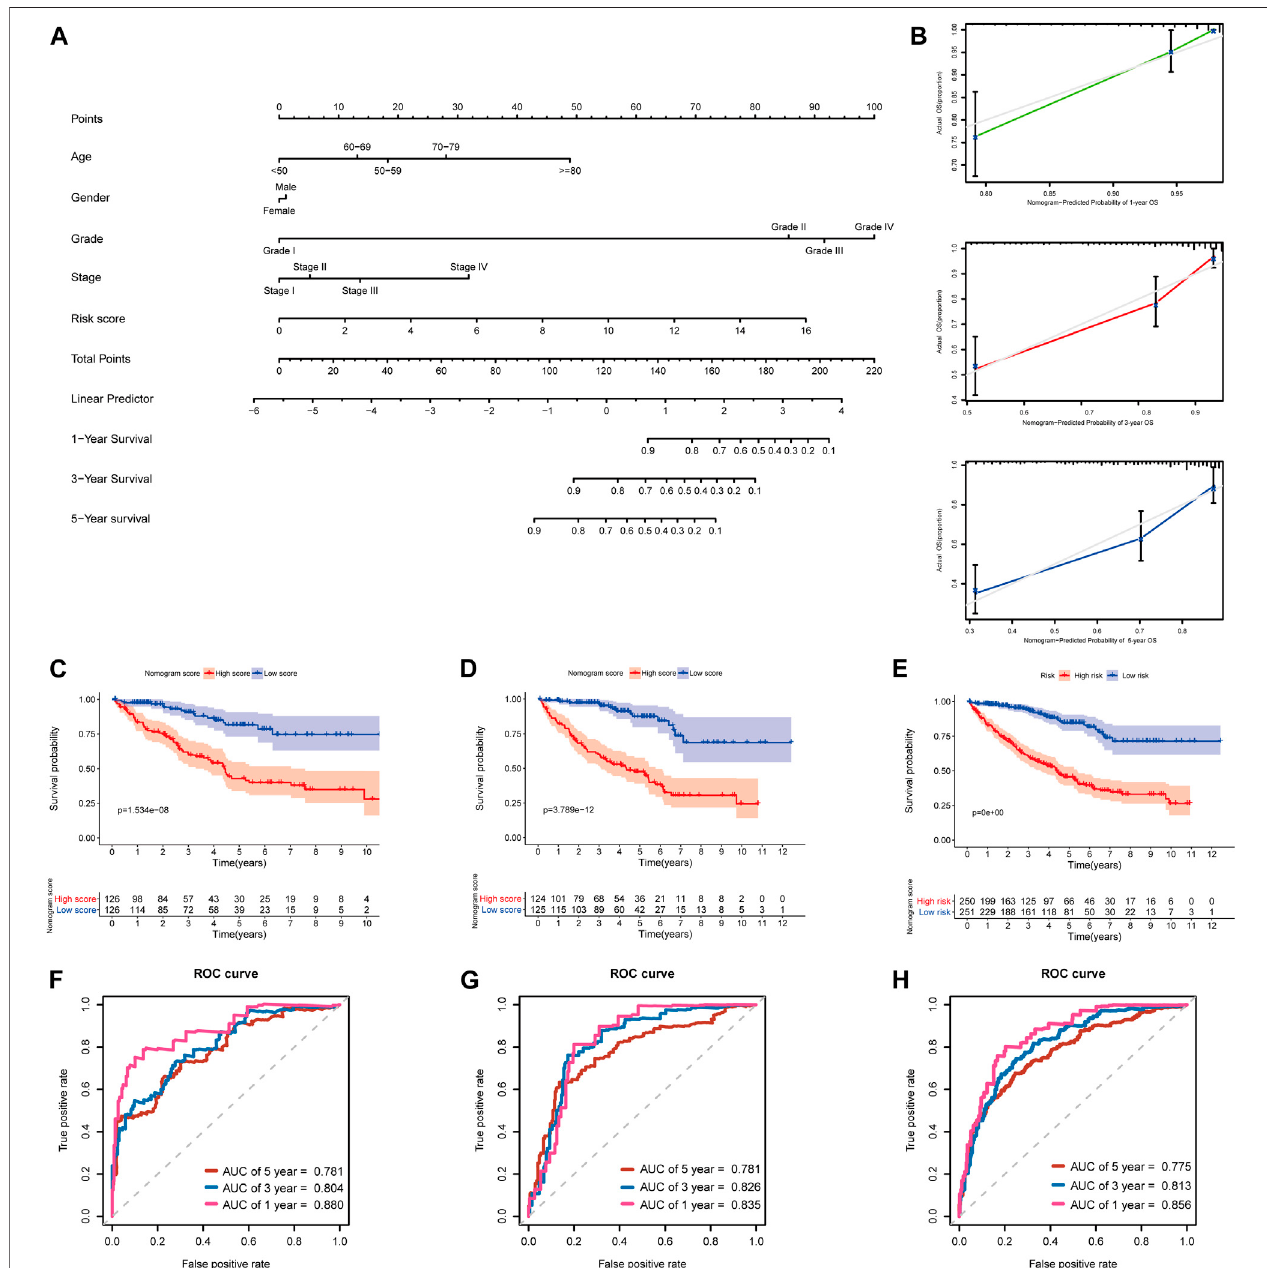
FIGURE 11 | Developing and validating a nomogram for predicting prognosis in the TCGA-KIRC dataset. (A) Nomogram constructed in the training set to predict 1-, 3-, and 5-year OS; (B) Calibration plots of the nomogram for 1-, 3-, and 5-year OS; (C – E) Kaplan – Meier survival analysis based on the nomogram scores in the trainingset,testingset,andentireTCGA-KIRCcohort; (F – H) Time-dependentROCcurvesofthenomogramfor1-,3-,and5-yearOSinthetrainingset,testingset,and entire TCGA-KIRC cohort.